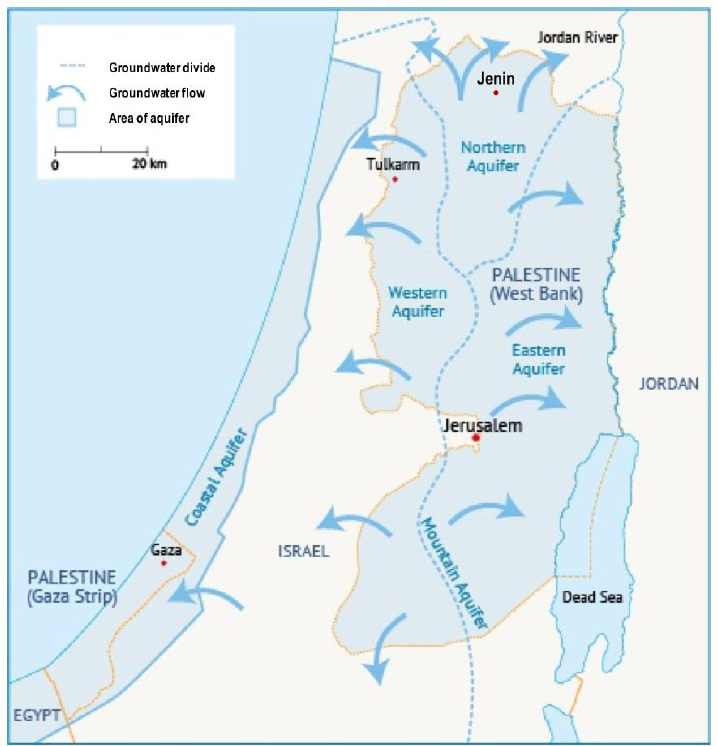
Figure 1. Main water resources of Palestine (Source: water.fanack.com/palestine/water-resources).